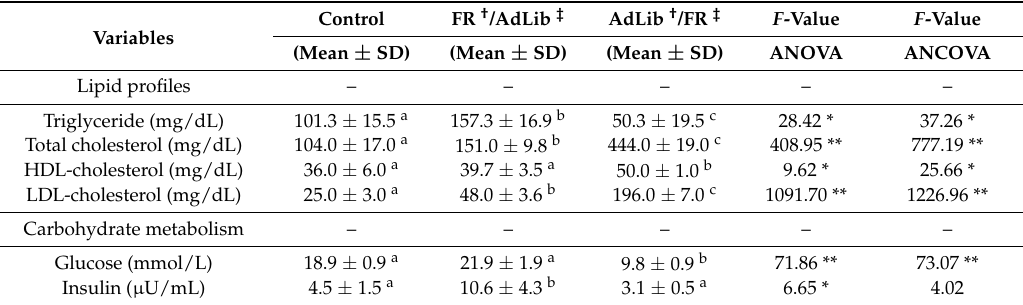
Table 2. Comparison of the plasma lipid and carbohydrate profiles in the offspring of AdLib- or FR-fed dams during pregnancy and